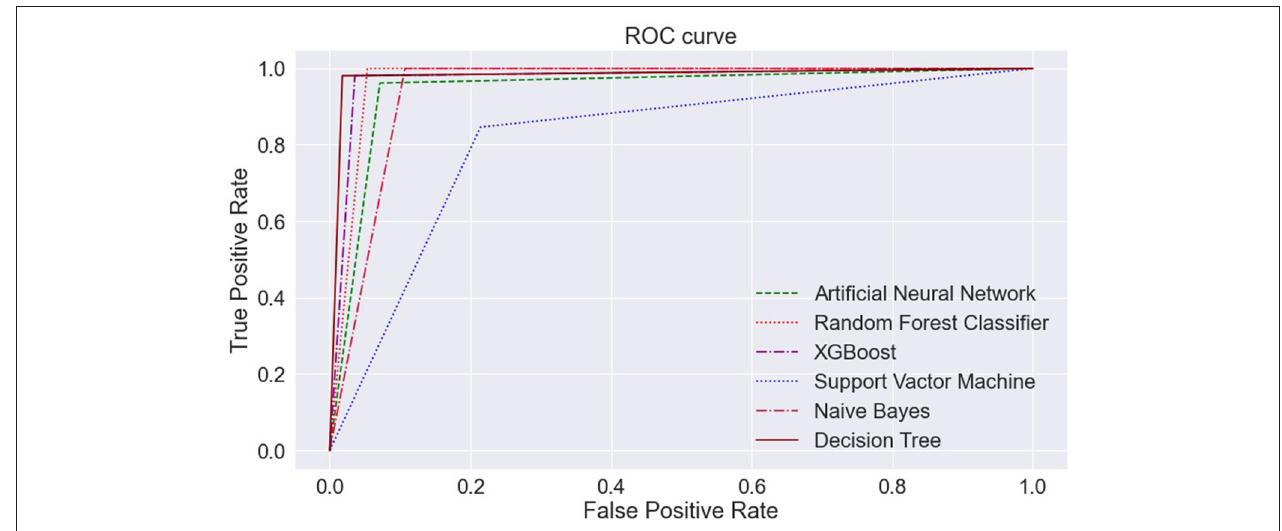
FIGURE 9 | Counts of cardiac arrest in men/women.